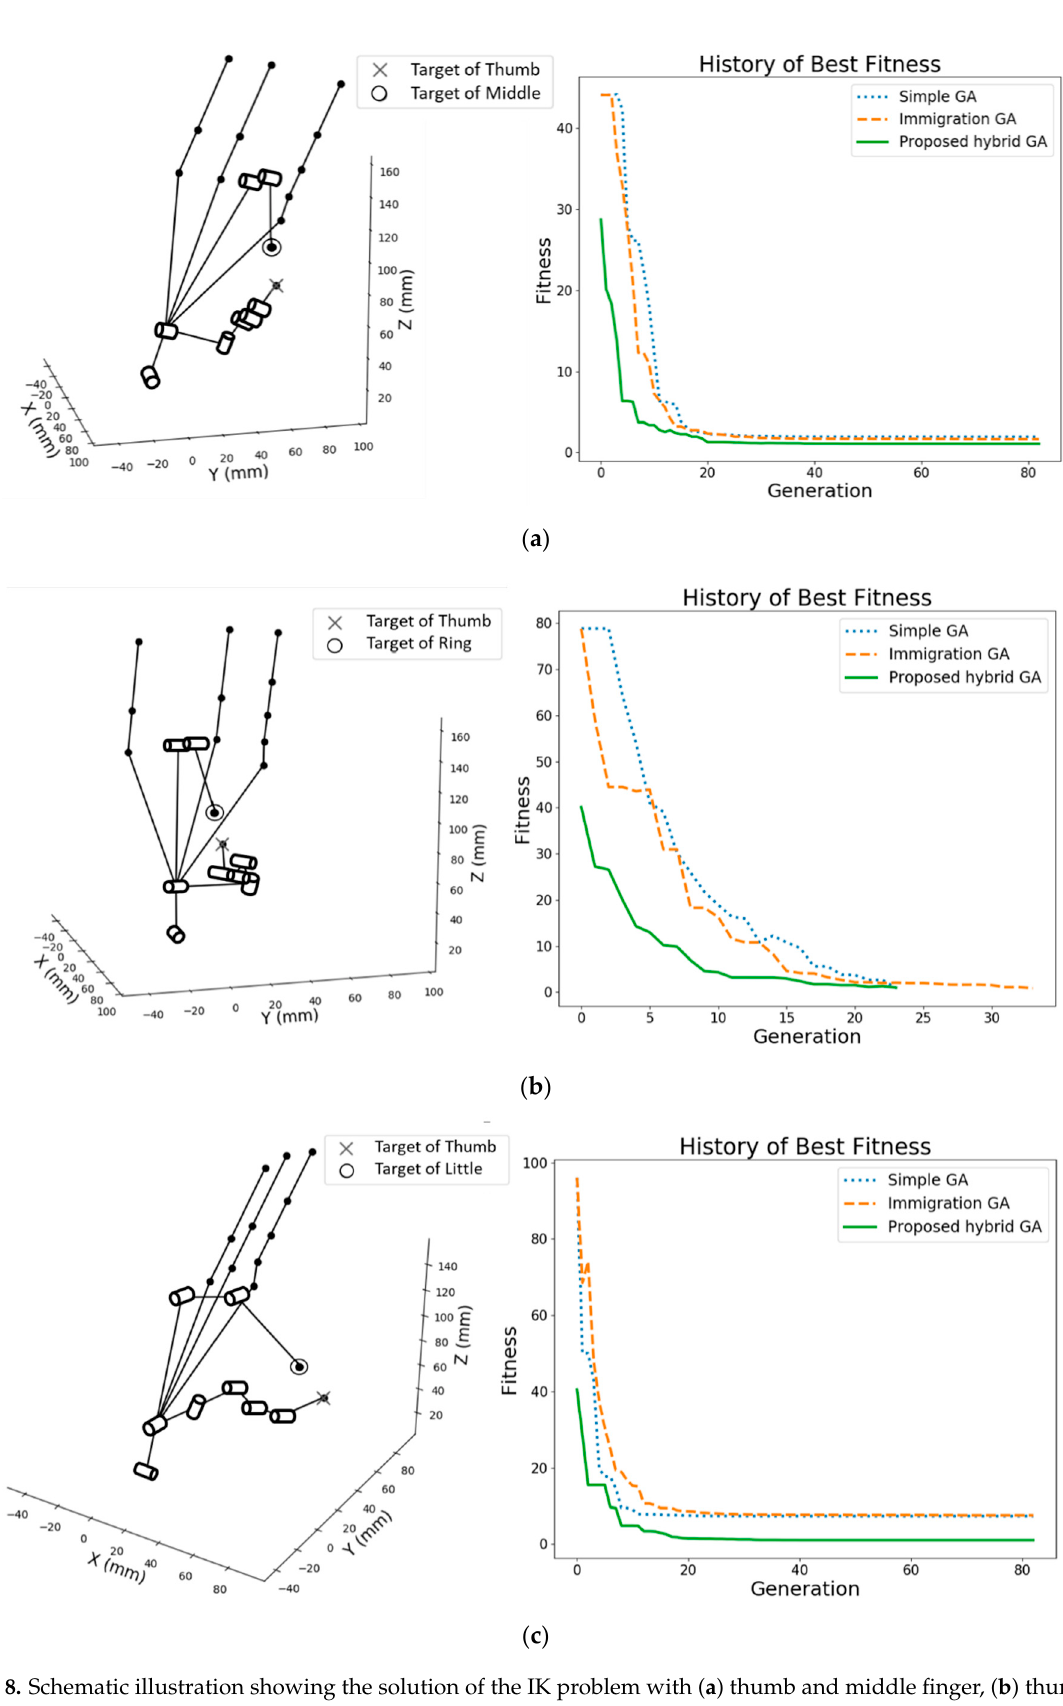
Figure 8. Schematic illustration showing the solution of the IK problem with ( a ) thumb and middle finger, ( b ) thumb and ring finger, and ( c ) thumb and little finger, as well as the corresponding fitness performance .